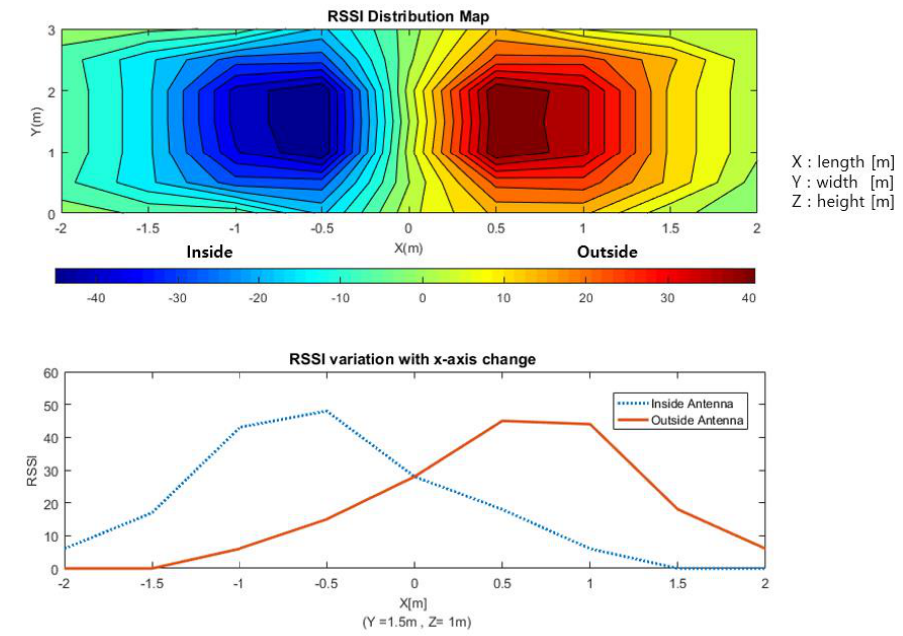
Figure 9. Comparison of LF signals for situation-awareness. (Experiment 1).